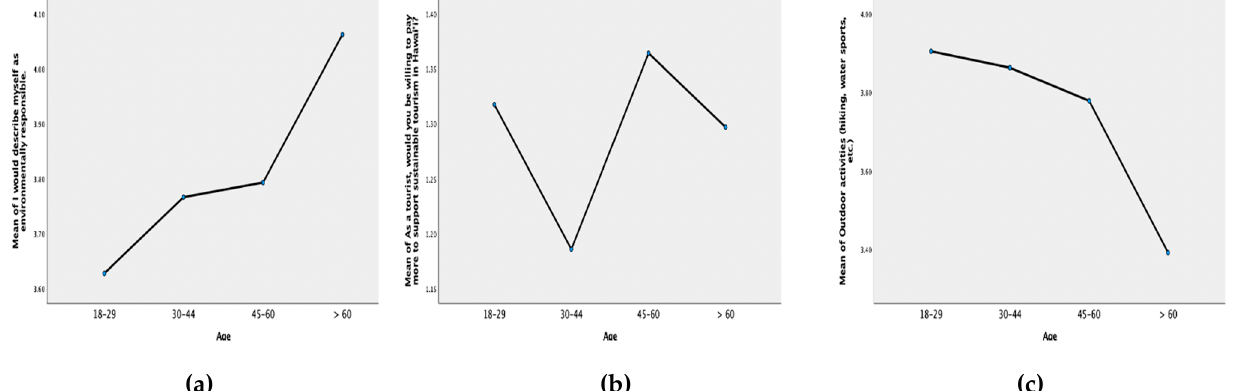
Figure 2. Tukey’s HSD comparisons of age groups. ( a ) I would describe myself as